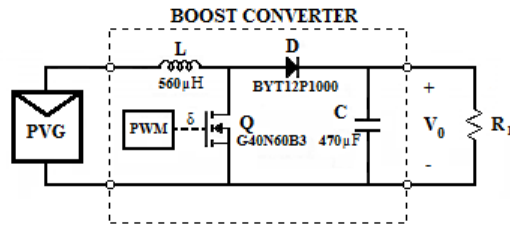
Figure 4. Boost DC/DC converter used in the simulations.